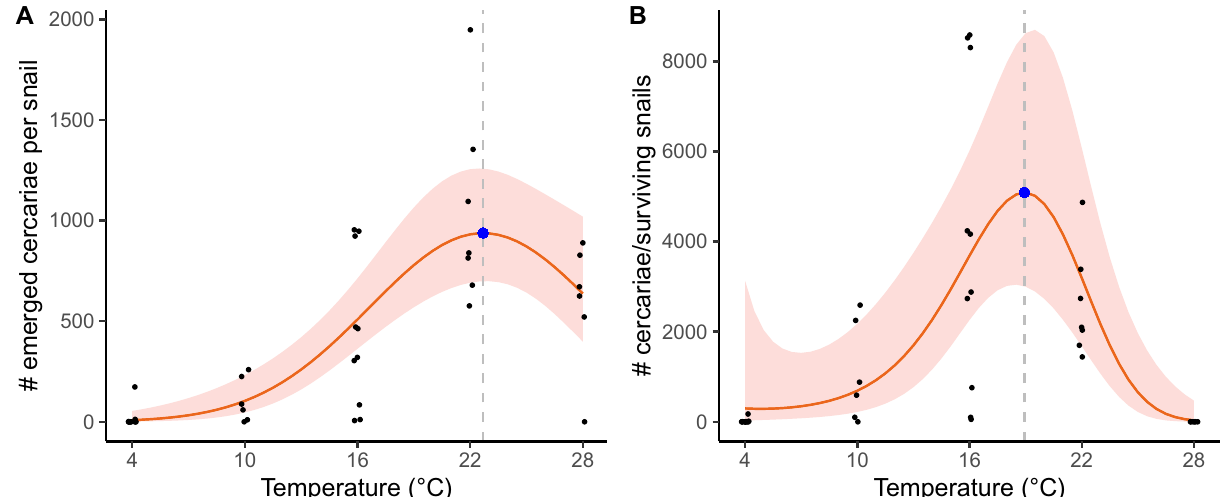
Figure 3. Cercarial emergence per snail ( A ) and net cercarial emergence per snails that survived from an initial population of 10 snails ( B ) over a 3-day incubation experiment in different temperatures. Regressions are based on generalized linear models with distributions of overdispersion-corrected Poisson ( A ) and zero- inflated negative binomial ( B ). The blue dot represents the optimal temperature [22.7 °C ( A ) and 18.9 °C ( B )] for cercarial emergence [938 cercariae per snail ( A ) and 5088 cercariae per survived snails ( B